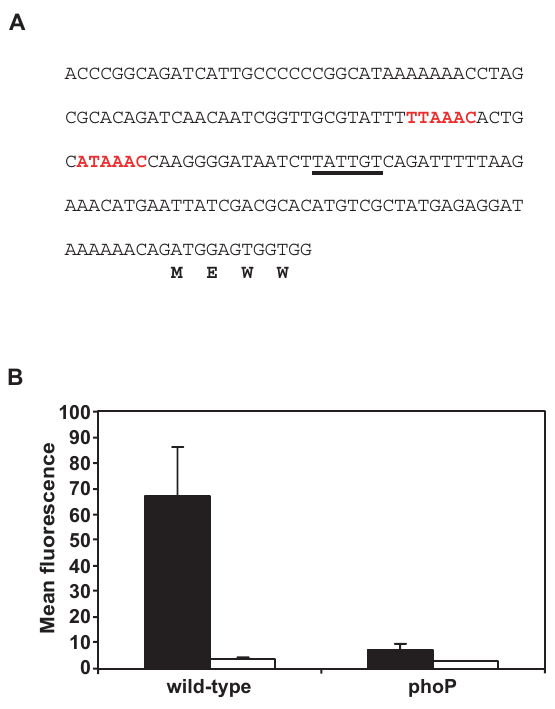
Figure 3. Expression of the K. pneumoniae pmrD gene is promoted in low Mg 2 + in a PhoP-dependent manner. (A) DNA sequence of the promoter region of the K. pneumoniae pmrD gene. The putative PhoP box [22] is in red and the putative 2 10 region is underlined. The first four amino acid residues of the pbgP ORF are indicated below the nucleotide sequence. (B) Fluorescence of a pmrD- gfp transcriptional fusion was measured in wild-type (EG13127) and isogenic phoP (EG15289) K. pneumoniae strains harboring the pAG- pmrD Klebsiella plasmid following growth in N-minimal medium, pH 7.7, containing 38 mM glycerol with either 10 m M (black bars) or 10 mM (white bars) Mg 2 + as described in Materials and Methods. Strains harboring the control pAG- rpmS plasmid and the pAG vector demonstrated constitutive fluorescence and no fluorescence in all growth conditions, respectively (data not